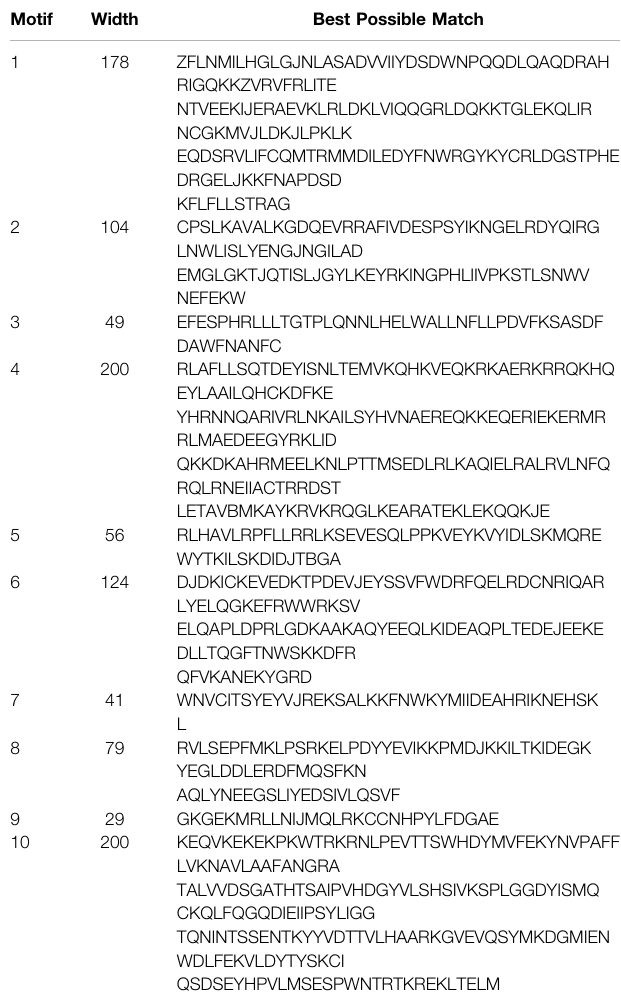
TABLE 2 | List of the putative motifs of SWI/SNF and ISWI remodelers. TABLE 3 | Different amino acid sites of catalytic subunits between MED and Asia